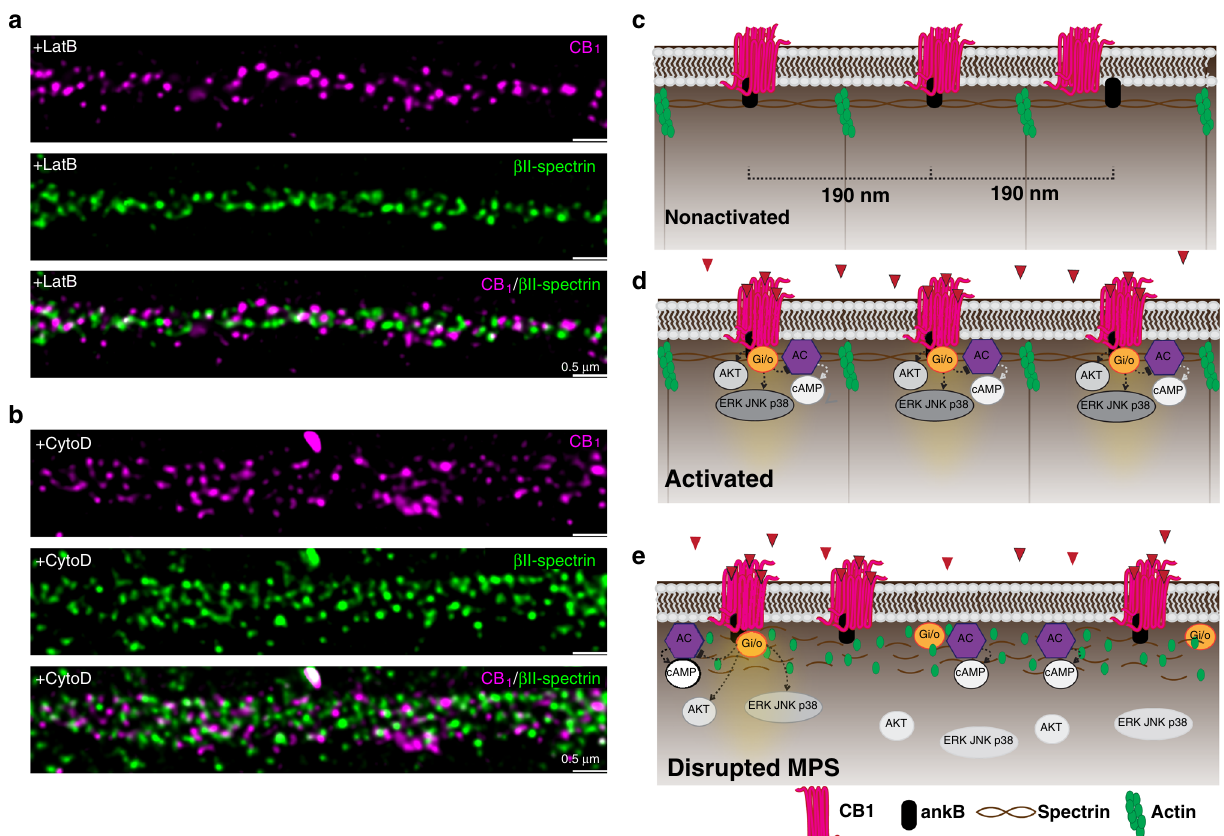
Fig. 5 Schematic illustration showing CB 1 forming dynamic peri-periodic hotspots to increase signaling ef fi ciency. a , b Two-color STED images of CB 1 (magenta) and β II-spectrin (green) in neurons treated with LatB ( a ) and CytoD ( b ). N = 3 biological replicates. c Without ligand binding, MPS sets the range for CB 1 distribution. d Upon ligand binding, active CB 1 are recruited to the MPS and become more periodic, making downstream AKT and ERK signaling more effective. e MPS degradation leads to less strong periodic clusters of CB 1 and thus less downstream